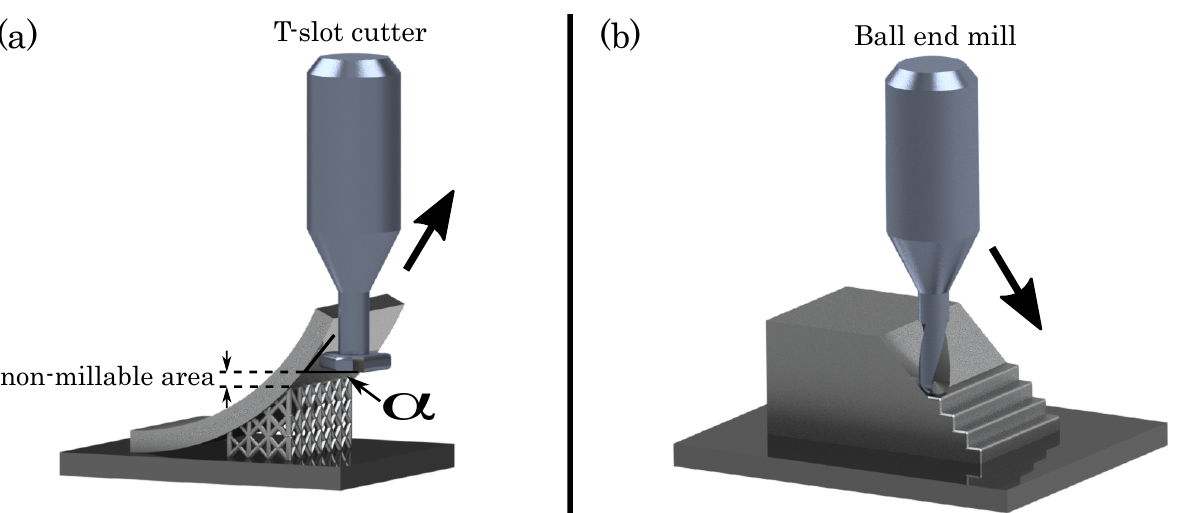
Figure 6. ( a ) Limitation of the hybrid manufacturing process of inclined structures, moving upwards ( b ) Removing of the staircase-effect by the milling cutter, moving